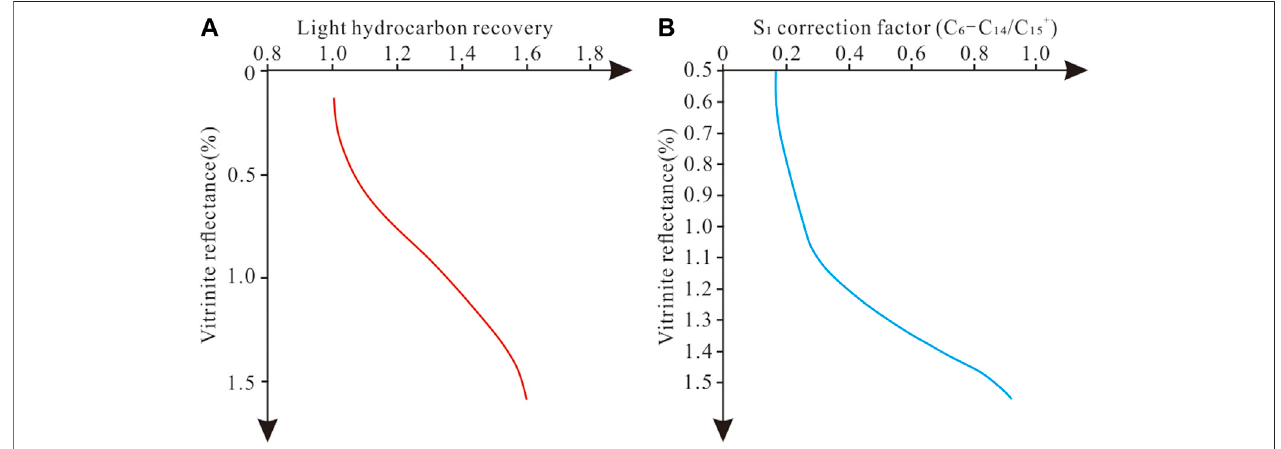
FIGURE 3 | Relationship between light hydrocarbon correction coef fi cient and maturity for shales. (A) From Li J. B. et al. (2020b); (B) from Wang et al. (2014).